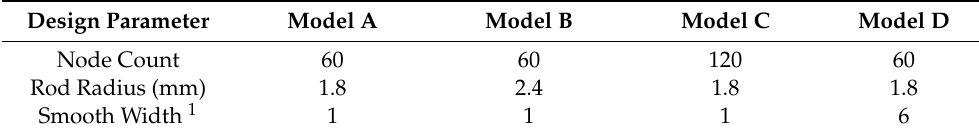
Table 1. Design parameter value changes for Figure 8 models.